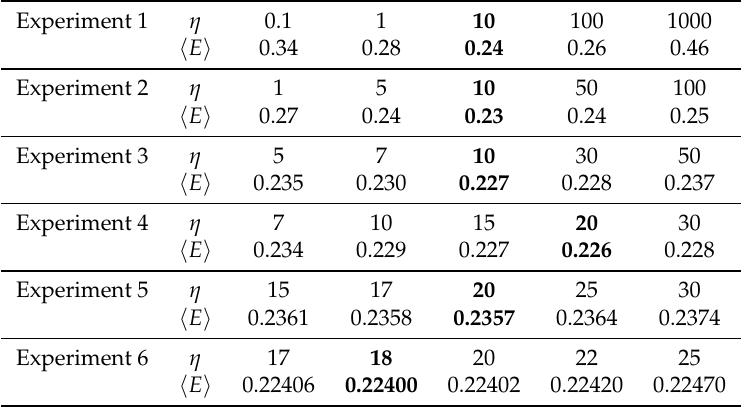
Table A1. Results of the experiments to identify the almost optimum value of η giving the smallest (cid:104) E (cid:105) when Correlation is Accounted for (CA).